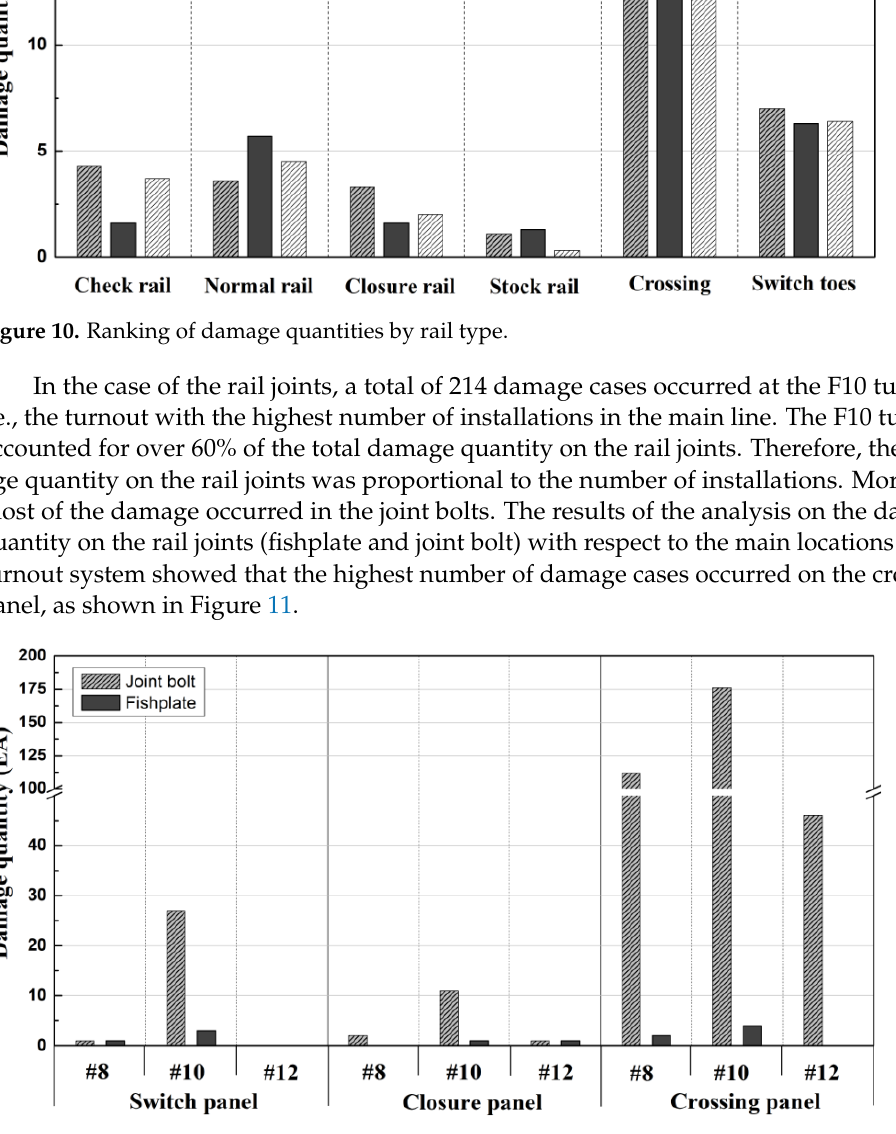
Figure 11. Damage status of rail joints.